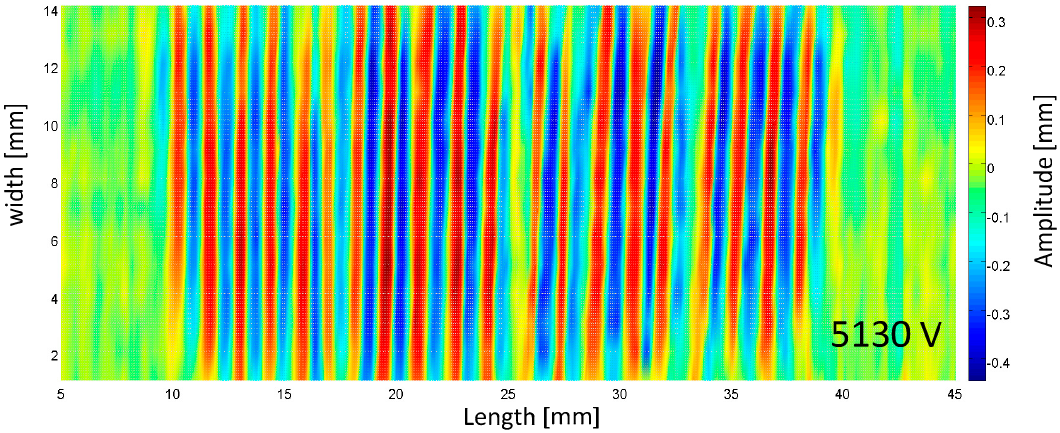
Figure 5. The characterization of the wrinkled hydrogel surface.